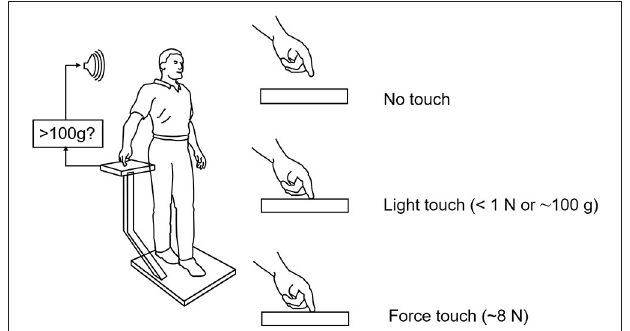
FIGURE 2 | Typical test situation for our light-touch stabilization of posture studies. The alarm sounds when the force on the finger touch plate exceeds 1N ( ≈ 103g). Subjects in practice never reach this force level in their experimental trials. The alarm is off during force touch trials.